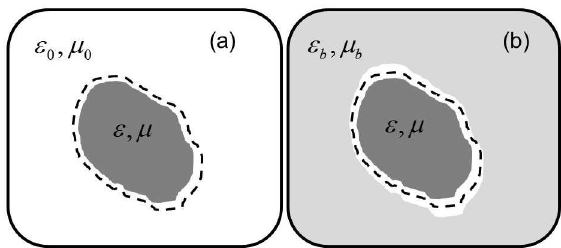
Figure 1: Illustration of total force calculation within a vol- ume V within the dashed line. The total force on (a) an object in vacuum is computed by volume integration of a force density within a region which completely encloses the material object and (b) an object embedded is computed in a similar way by considering a thin vacuum region between the two